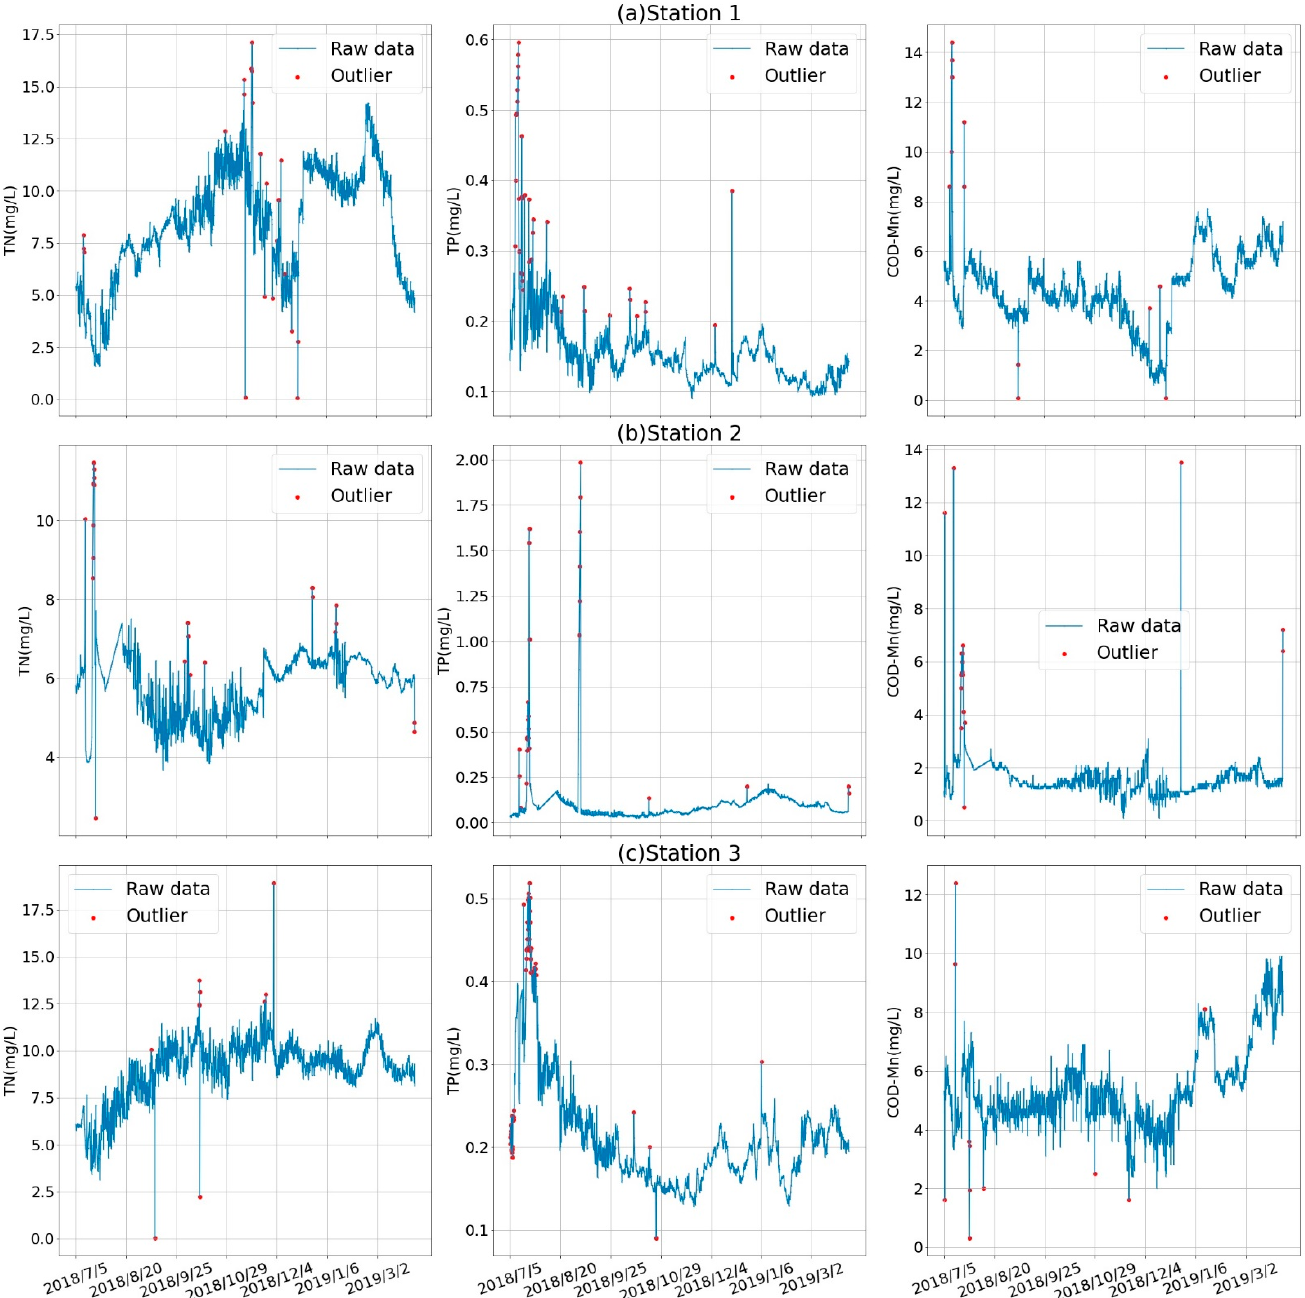
Figure 6. ( a ) The entire time series and outliers of TN, TP, and COD-Mn in station 1. ( b ) The entire time series and outliers of TN, TP, and COD-Mn in station 2. ( c ) The entire time series and outliers of TN, TP, and COD-Mn in station 3.